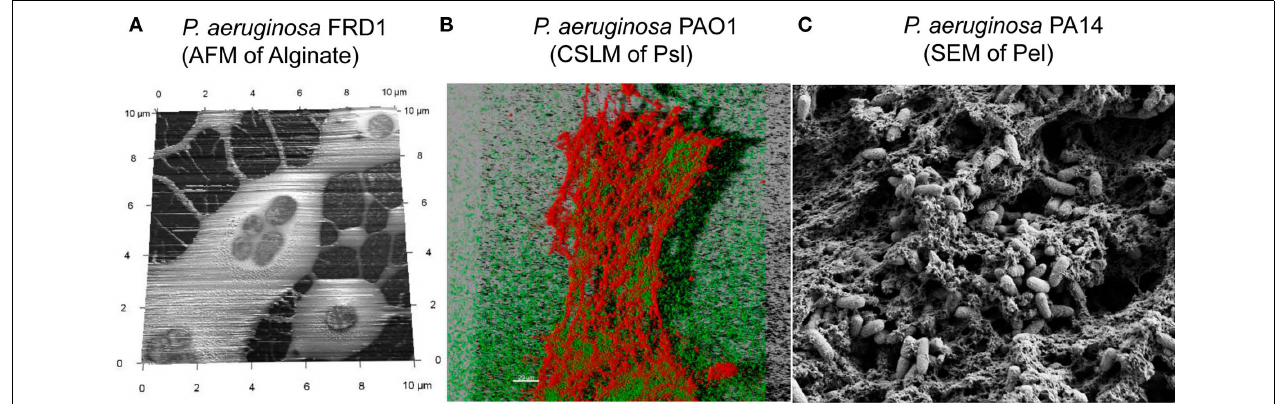
expressing the green fluorescent protein and the Psl polysaccharide counterstained with CellMask Orange (Invitrogen Corp.). (C) Scanning Electron Microscopy image of P. aeruginosa PA14, cultured as a pellicle.The image shows the extracellular matrix, which includes Pel, as a fabric-like matrix that surrounds and connects the cells that form a microbial mat at the air-water